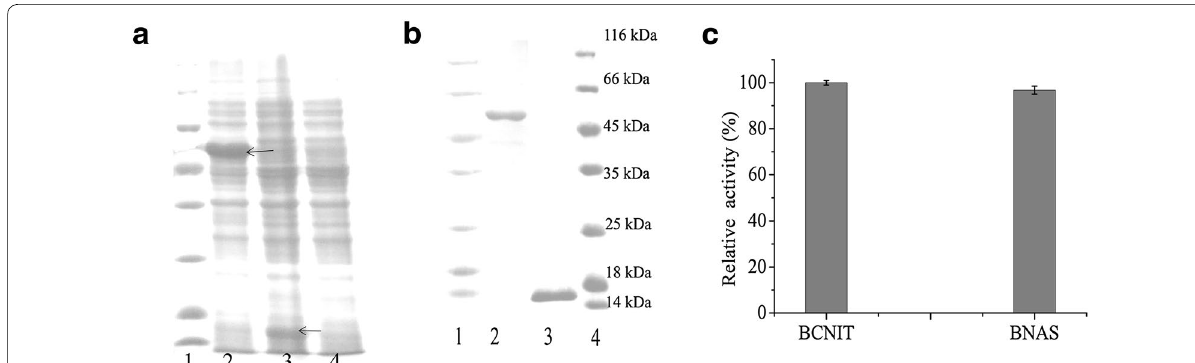
Fig. 2 Expressions of BNAS and SspB proteins in E. coli BL21 (DE3) cells. a SDS-PAGE image of the cells expressing BNAS and SspB at 20 h after IPTG addition. Lanes 1 marker; lane 2 BNAS; lane 3 SspB; lane 4 control. The arrow shows the destination band. b SDS-PAGE analyses of purified BNAS and SspB in vitro. Lanes 1 and 4 marker; lane 2 purified BNAS; lane 3 purified SspB. c Comparison of the enzyme activities of BCNIT and BNAS in vitro. The determination of nitrilase activity was performed at 30 °C for 30 min with 10 µM FMN under 470-nm blue light illumination. Under the experimental conditions, the relative activity was expressed as a percentage of the maximum activity. Error bars represent the standard error of three